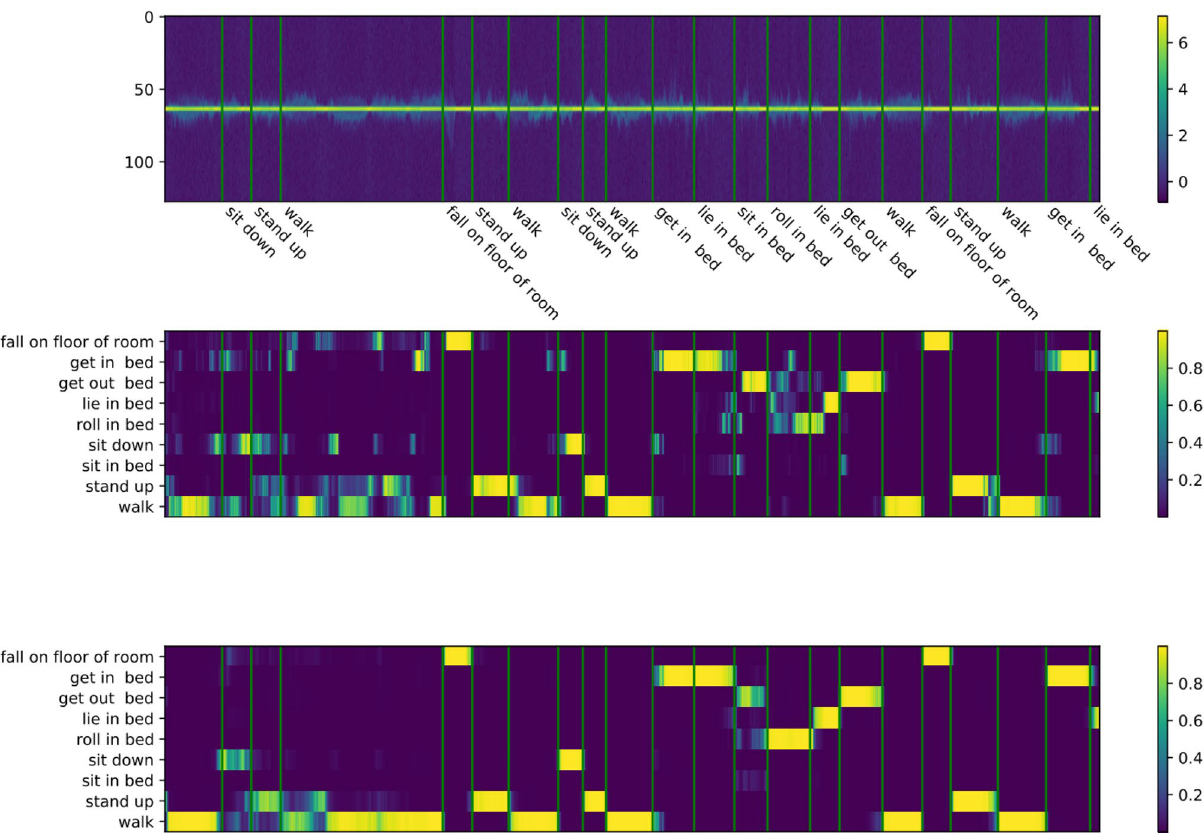
Figure 1. (Top) MD signatures over time in dB (middle) unidirectional RNN over time with classes on the y axis with activities annotated with vertical green lines. The color scale visualizes the confidence ∈ [ 0, 1 ] of the model in a class. (Bottom) Bidirectional RNN over time with classes on the y axis. The color scale visualizes the confidence ∈ [ 0, 1 ] of the model in a